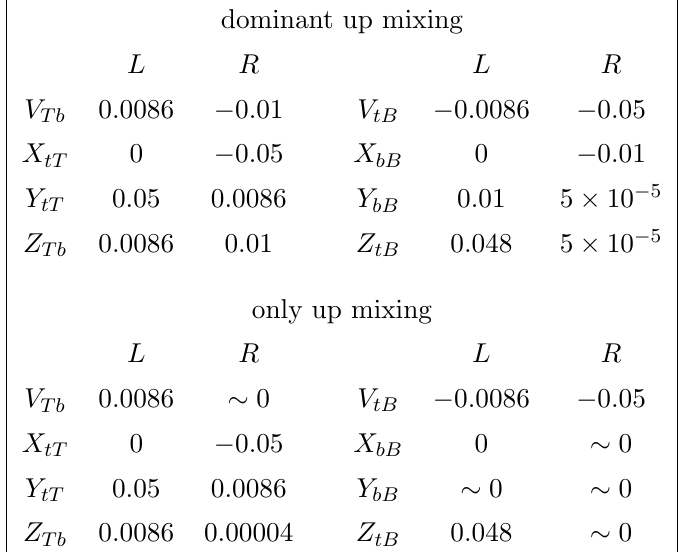
Table 2 . Top: couplings for the up-mixing scenario with s u (for which s u = 0 : 0086, s d L s d (cid:24) 0). L